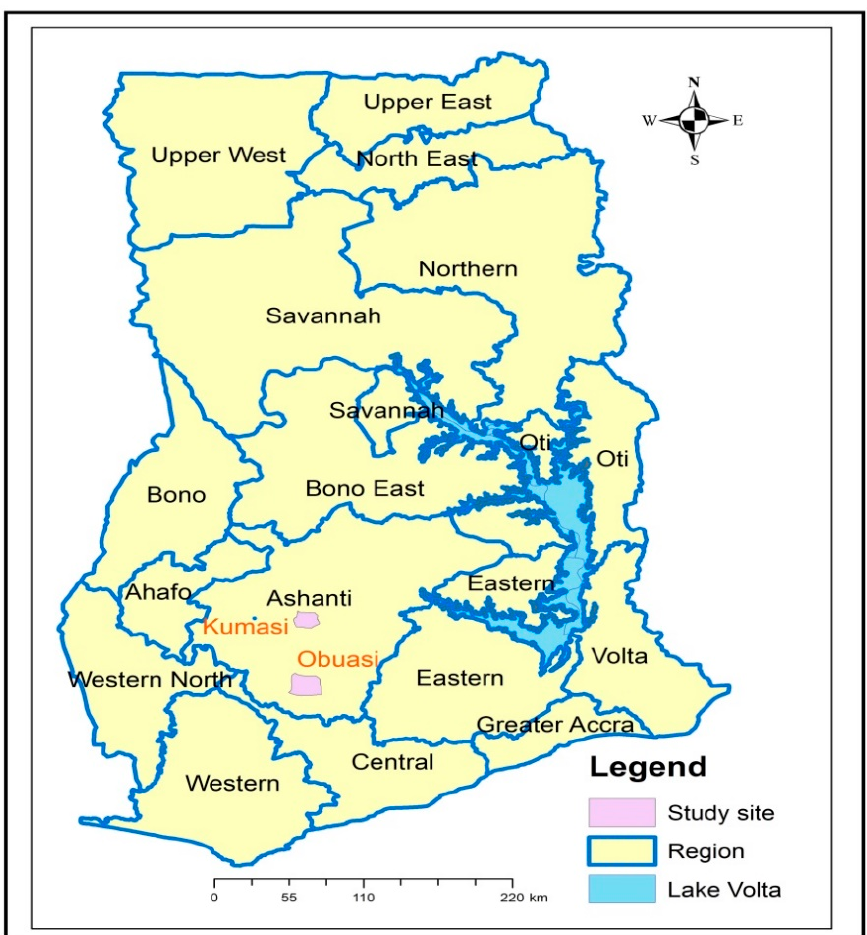
Figure 1. Map of Ghana showing the study sites.